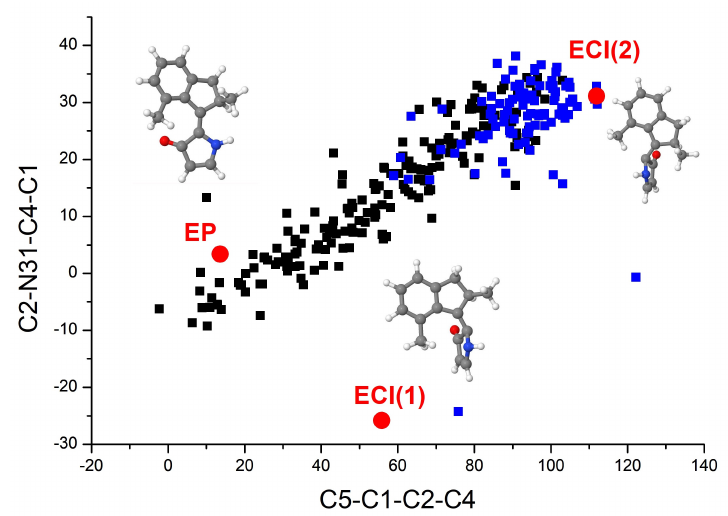
Figure 4. Distribution of the C5-C1-C2-C4 and C2-N31-C4-C1 dihedral angles at the hopping events of 275 trajectories starting from the EP structure of DDIY. Black squares denote trajectories returned to the reactant EP isomer, while blue squares denote trajectories experienced EP → ZP photoisomerization. The ground state EP isomers, ECI(1) and ECI(2) are also presented in this